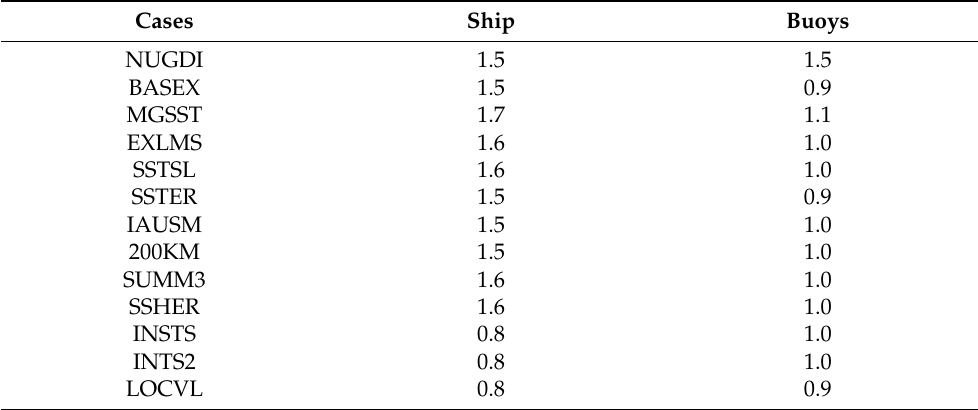
Table 4. As in Table 3, except for the observed data locations. “Ship” means the data obtained from the research vessel “Tosa Kaiyou Maru” (see Figure 11b for data locations), and “Buoys” means the data measured at the mooring buoys (No. 09, 10, 12, 13) around Tosa Bay (see Figure 8 for the